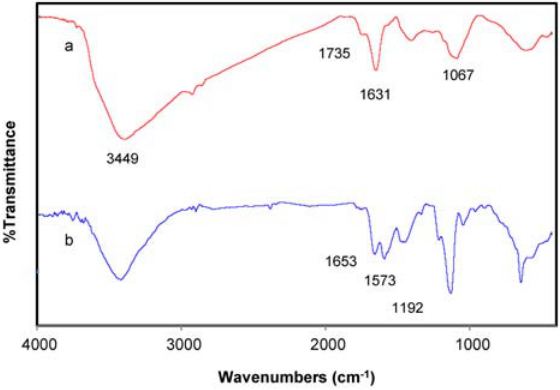
Fig. 1. FT-IR spectra of (a) GO and (b) GO-9-AA